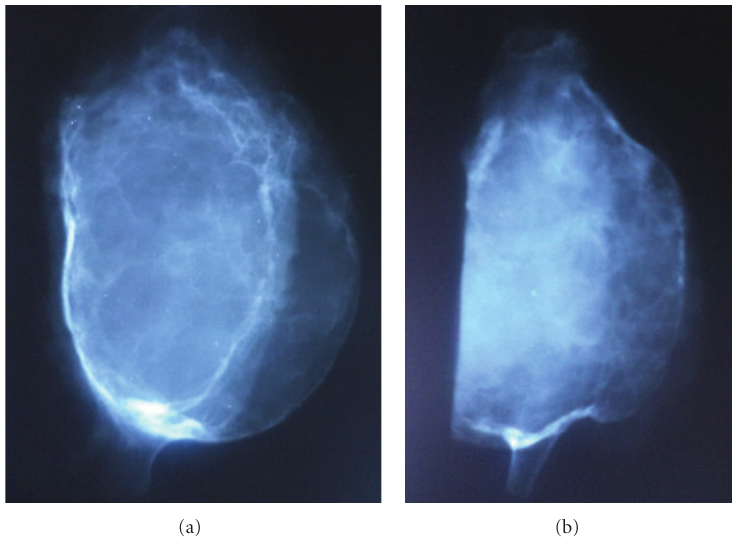
Figure 3: The specimen X-ray ((a) and (b)) displaying the intact lesion with no soft tissue extension.